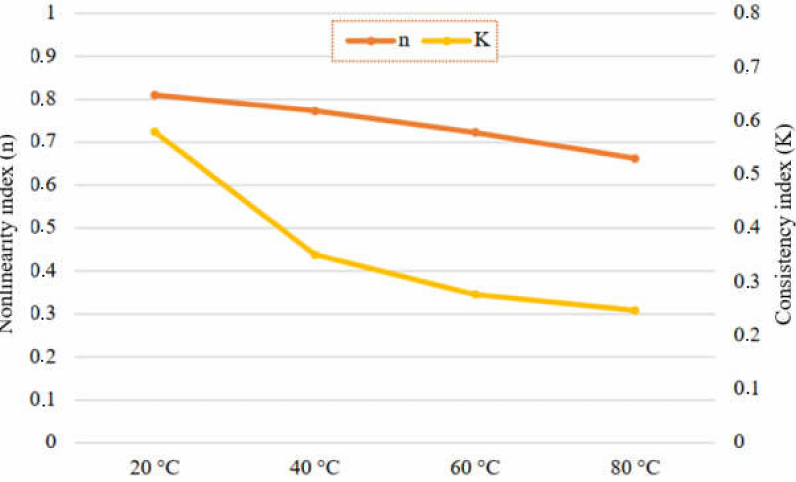
Figure 8. Change in the rheological coefficients of the HBM at different